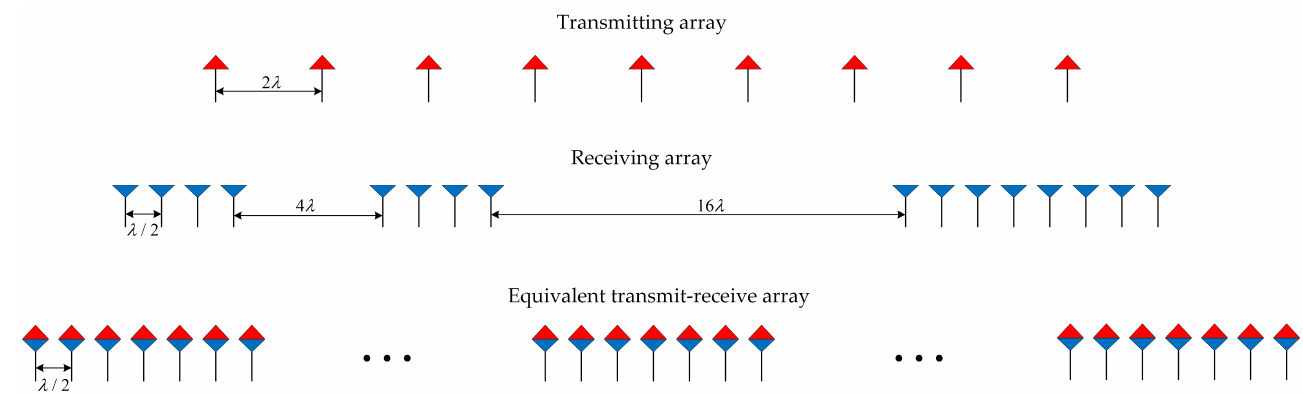
Figure 10. Array structure of AWR2243 cascaded